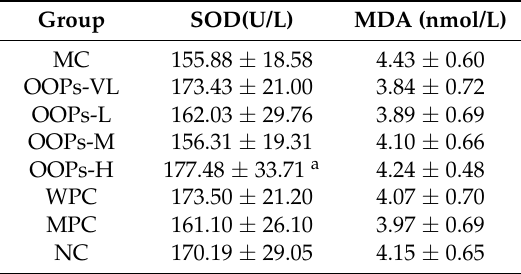
Table 5. Effect of OOPs treatment on the SOD and MDA.